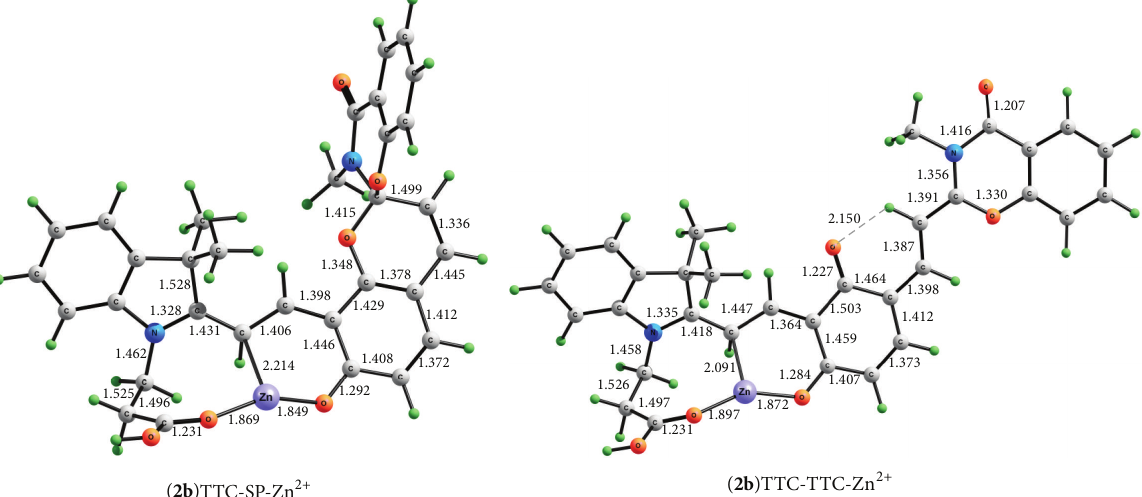
Figure 6: Structural properties of complex compounds ( 2b )TTC-SP-Zn 2+ and ( 2b )TTC-TTC-Zn 2+ calculated at the CPCM/PBE0/6-311G ∗∗ level of theory (acetonitrile